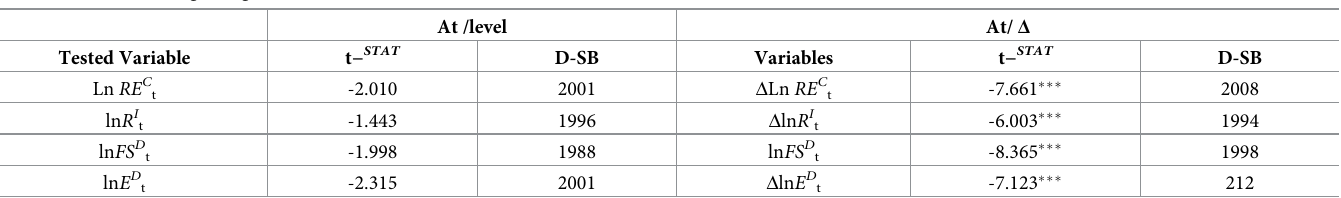
Table 4. The Perron-Vogelsang test results.